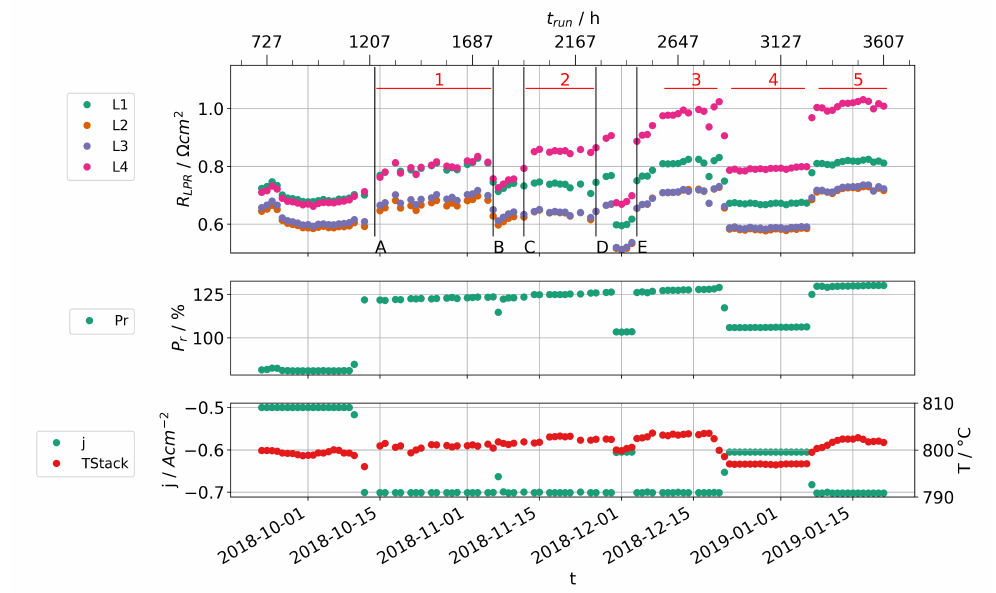
Figure 4. Daily averaged cell resistances by the LPR method (top), relative power (center), current density, and stack temperature (bottom) for stack A. Includes only the values measured at the same time as the intermittent LPR measurements, which were only recorded at 0.71 A cm − 2 . Specific events are marked with capital letters, and operational phases with red